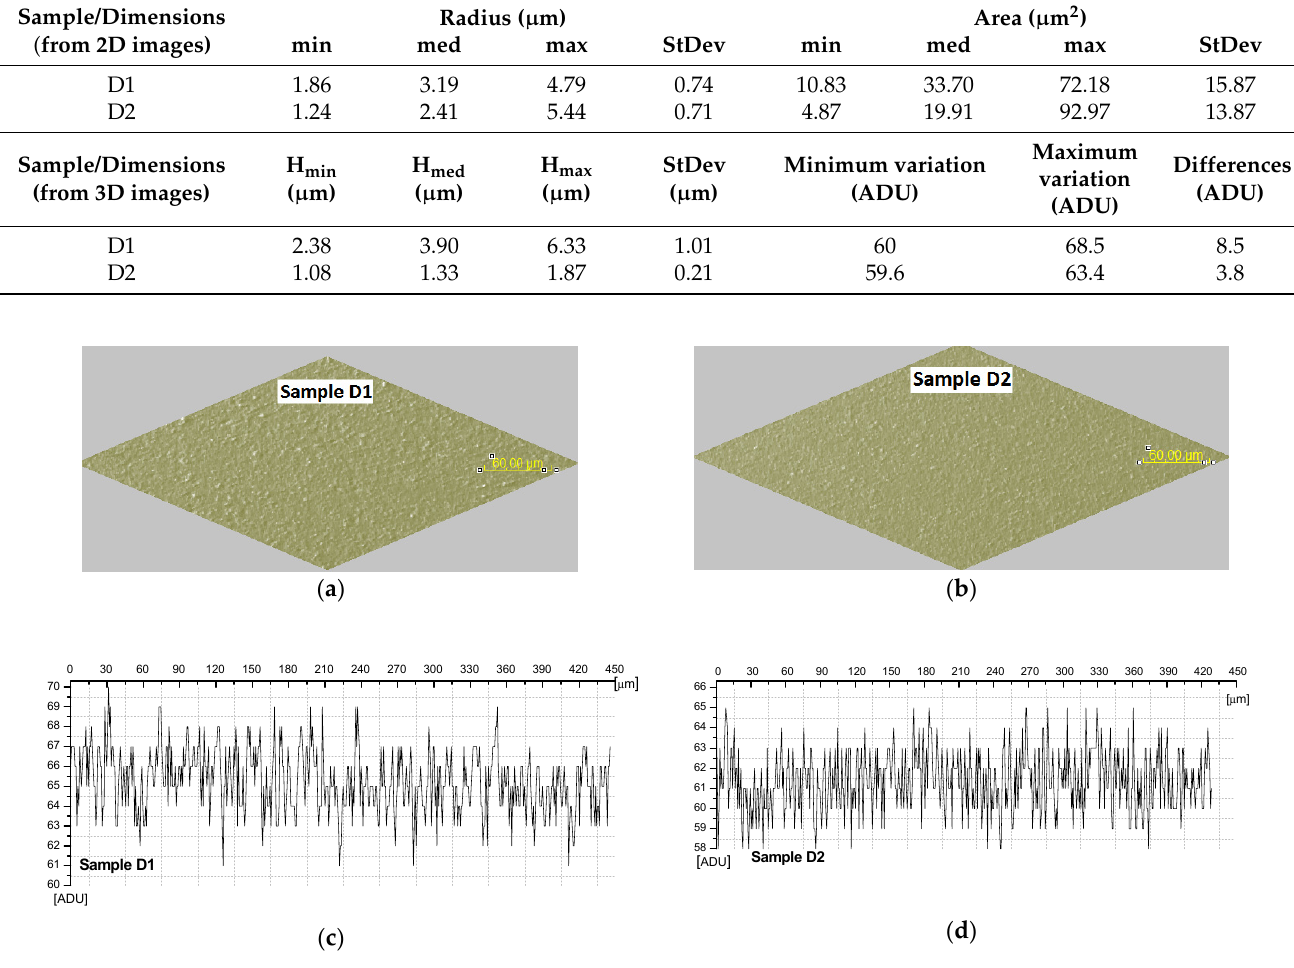
Figure 3. 3OOOD images of sample surfaces: (a) D1 and (b) D2. Surface roughness distribution: (c) Figure 3. 3D images of sample surfaces: ( a ) D1 and ( b ) D2. Surface roughness distribution: ( c ) D1 and ( d ) D1 and (d) D2.